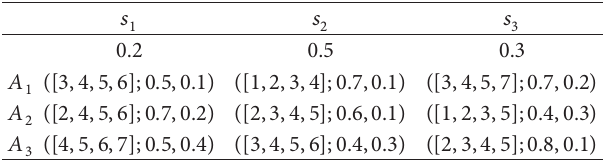
Table 4: Prospect information for attribute 𝑐 4 .